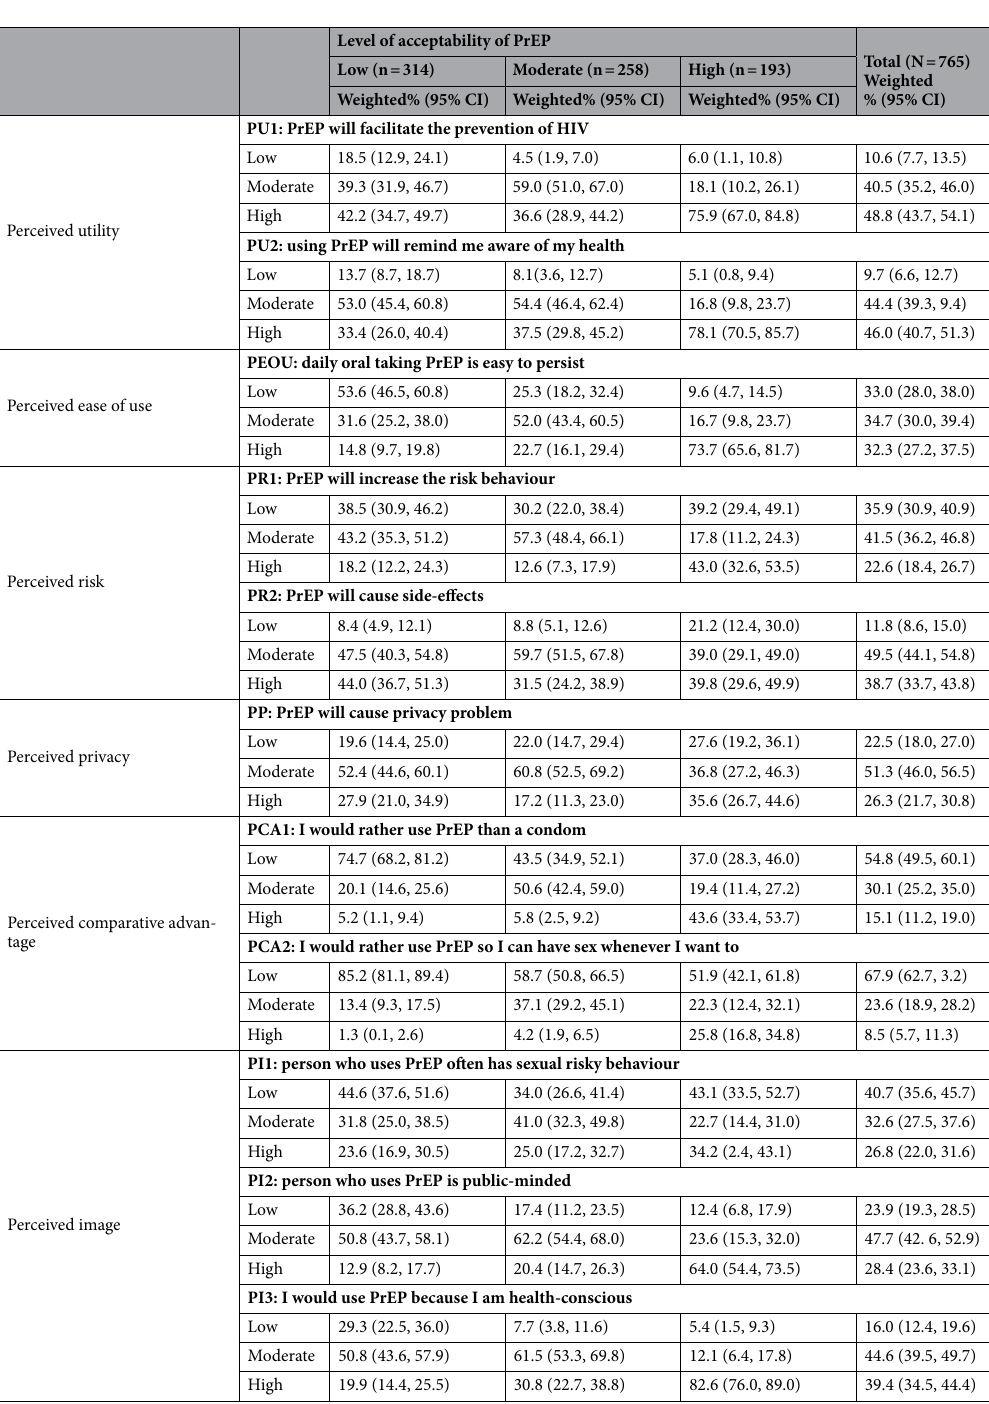
Table 2. Distribution of criteria linked to PrEP acceptability among people at risk for HIV. PrEP pre-exposure prophylaxis, PU1 perceived utility of PrEP in facilitating prevention of HIV, PU2 perceived utility of PrEP in reminding health awareness, PEOU perceived ease of use, PR1 perceived risk of PrEP in increased risk behavior, PR2 perceived risk of side-effects, PP perceived privacy problem, PCA1 perceived comparative advantage over condom use, PCA2 perceived comparative advantage of having sex when the urge arises, PI1 perceived image of user as having sexual risky behavior, PI2 perceived image of user as public-minded, PI3 perceived image of user as